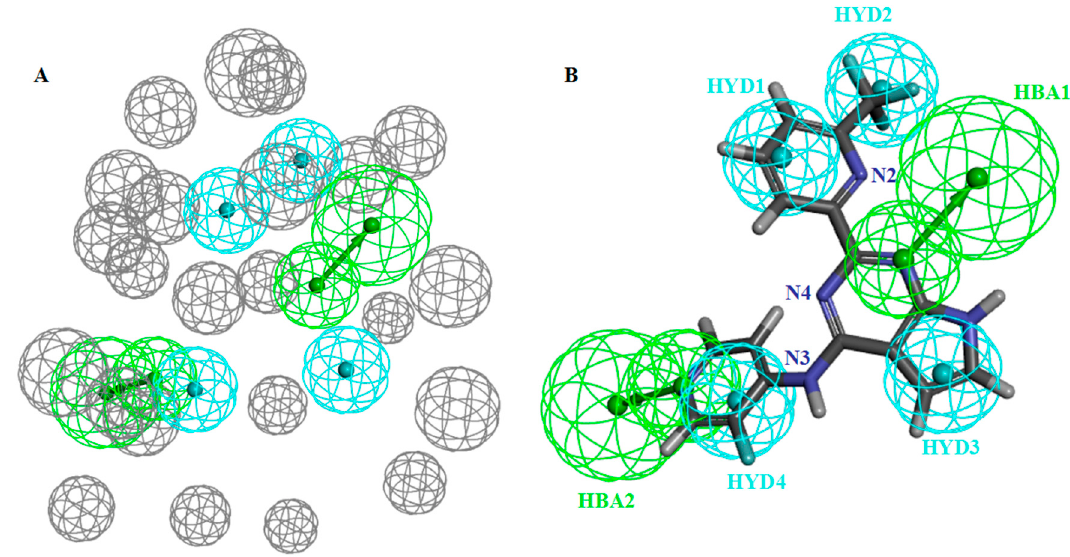
Figure 3. ( A ) Pharmacophore model A02 (hydrogen bond acceptors in green balls; hydrophobic properties in blue balls; the exclude volumes in gray balls) and ( B ) superposition with compound BMS22 (gray balls were hidden).